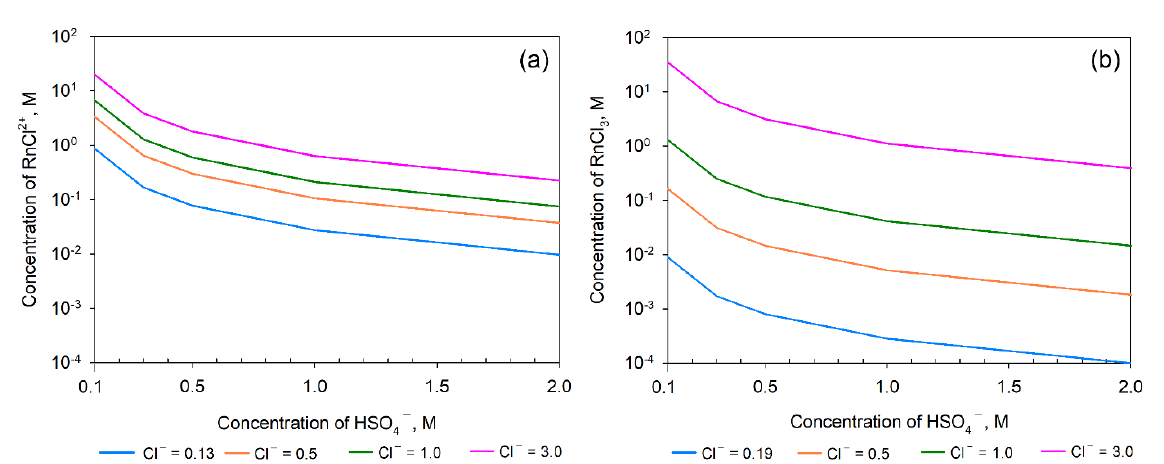
Figure 6. Effect of Cl − on the precipitation of ( a ) RnCl 2+ ; and ( b ) RnCl 3 .